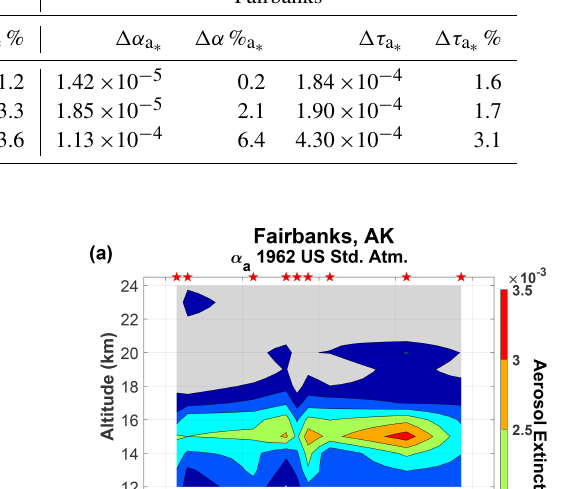
and α a , as well as τ a and τ a . ∗ ∗ US US Lexington Fairbanks